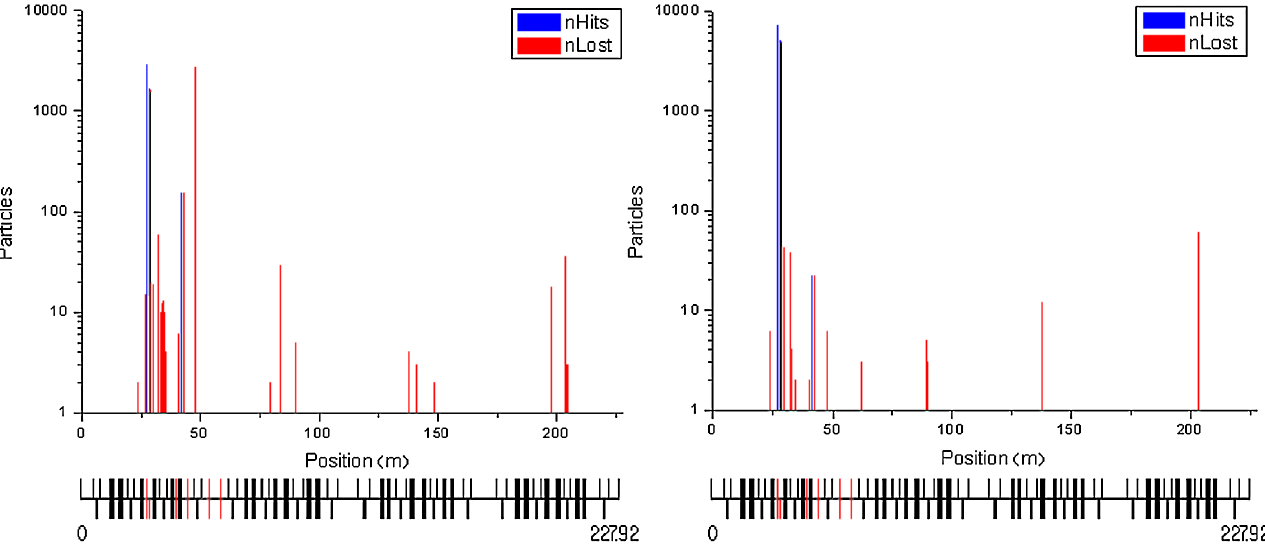
FIG. 10. Lost particles and the corresponding positions in the ring for the core collimation ( (cid:1) ¼ (cid:1) 1 : 85% ) at 80 MeV. nHits and nLost have the same meanings as in Fig. 4. A total of 10 000 particles are injected. Left: anticorrelated beam; right: correlated beam.